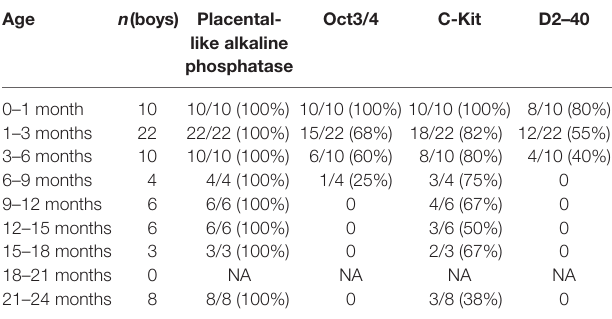
TaBle 1 | Number of boys with a positive reaction to each the immunohistochemical markers grouped by age in